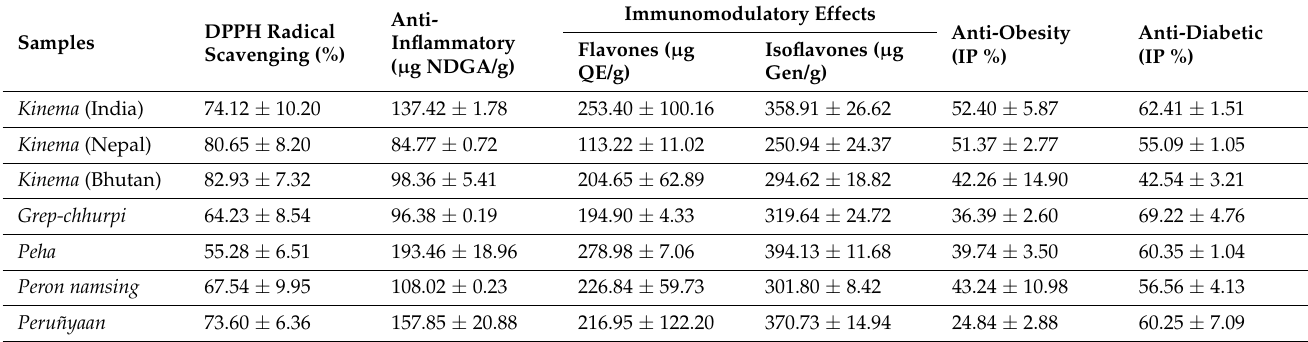
Table 2. Some therapeutic properties of naturally fermented soybean foods of the Eastern Himalayas.